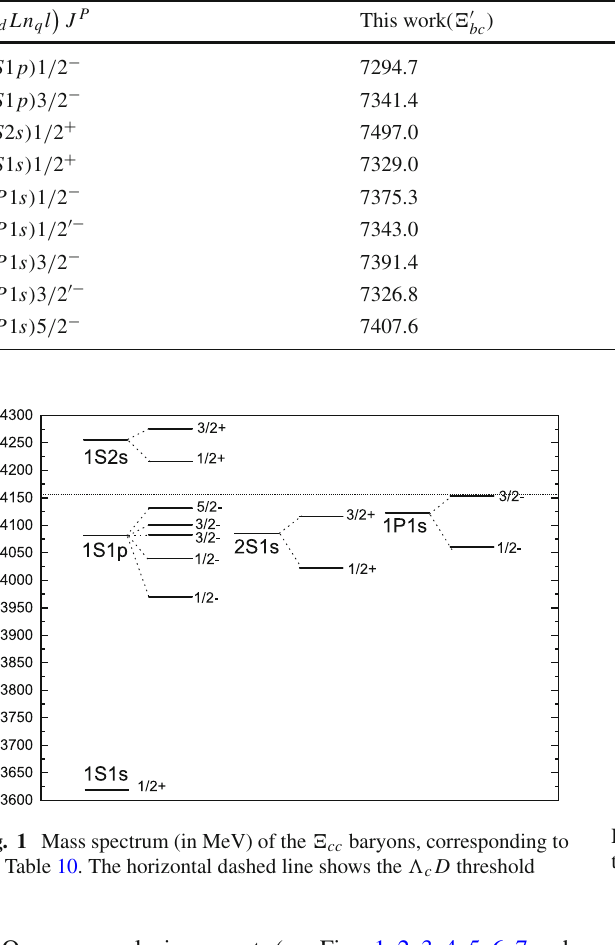
quantum numbers ( N , L ) and upon the effective mass of the quarks [35,36,51]. So, the prediction in Eq. (63) for the 1P- wave binding B ( b ¯ c ) and ensuing 1P-wave mass calculations of the baryon (cid:2) bc and (cid:3) bc are of approximated (uncertain within 10 MeV